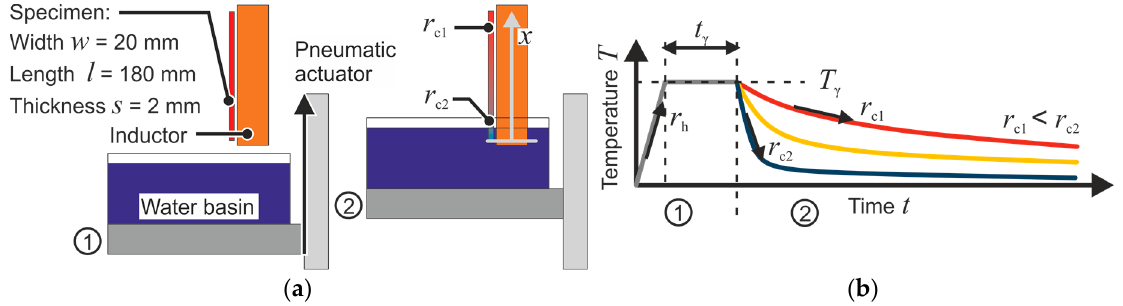
Figure 2. ( a ) Design of the quenching test with adjustable austenitizing temperature T γ and dwell times t γ and variating cooling rates r c [22]; ( b ) Schematic time-temperature curves during heat treatment by rapid heating and short dwell times.